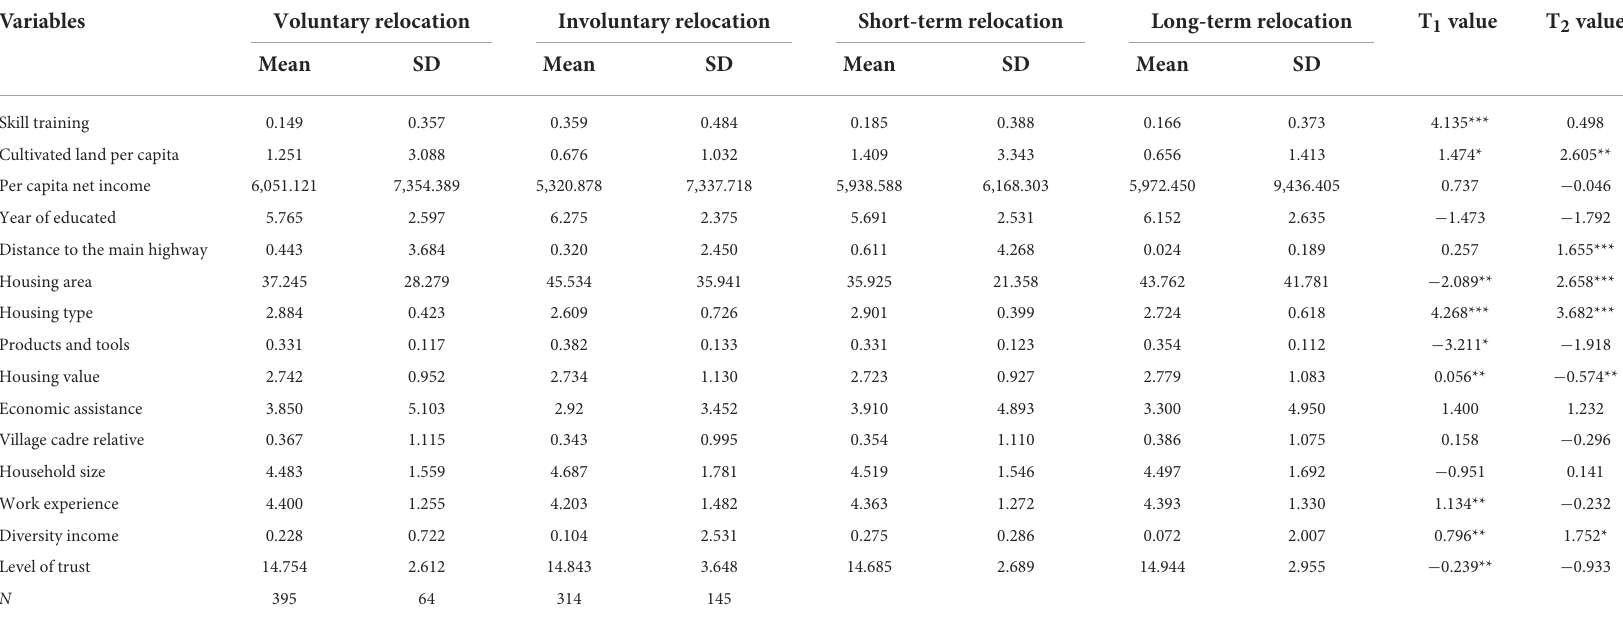
TABLE 2 Rural households’ capital characteristics for different resettlement types and